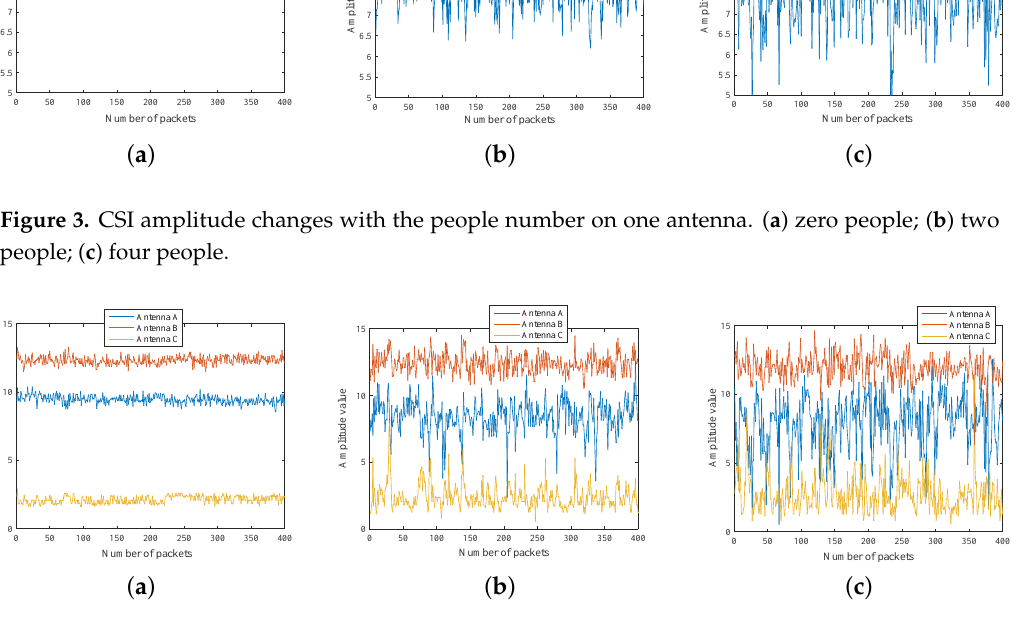
Figure 4. CSI amplitude changes with the people number on three antennas. ( a ) zero people; ( b ) two people; ( c ) four